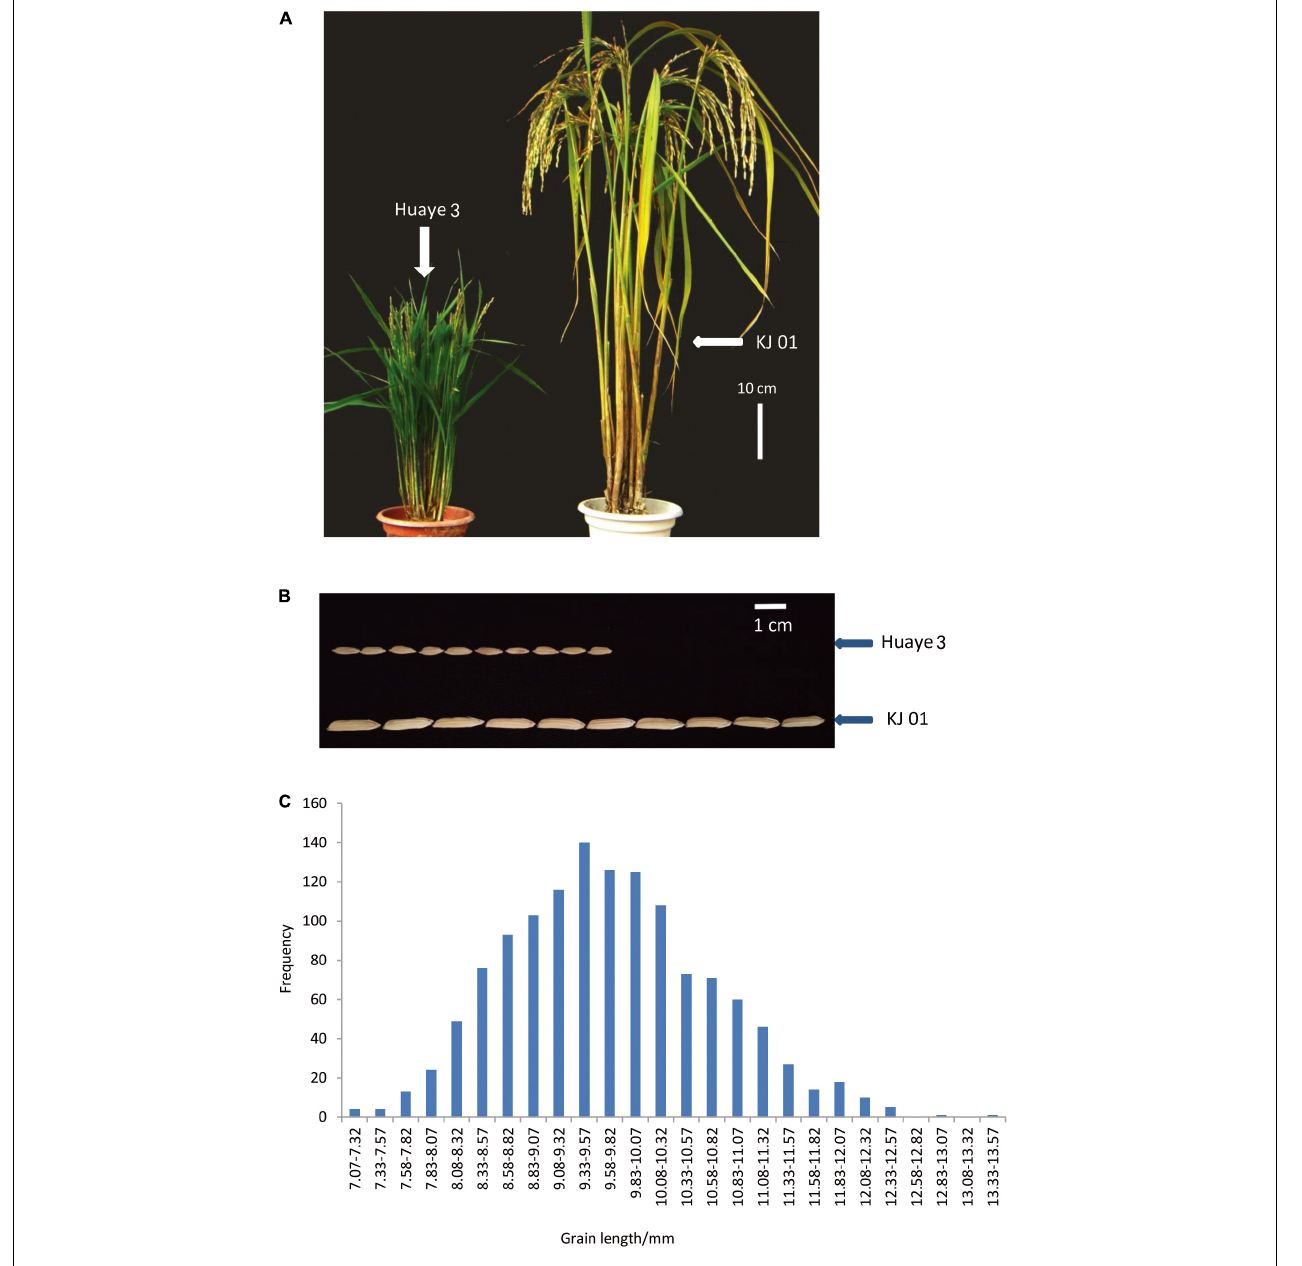
FIGURE 1 | Phenotypic analysis of the parents and frequency distribution of the F 2 individuals. (A) Plant type comparison of KJ01 and Huaye 3. (B) GL comparison of KJ01 and Huaye 3. and (C) frequency distribution of F 2